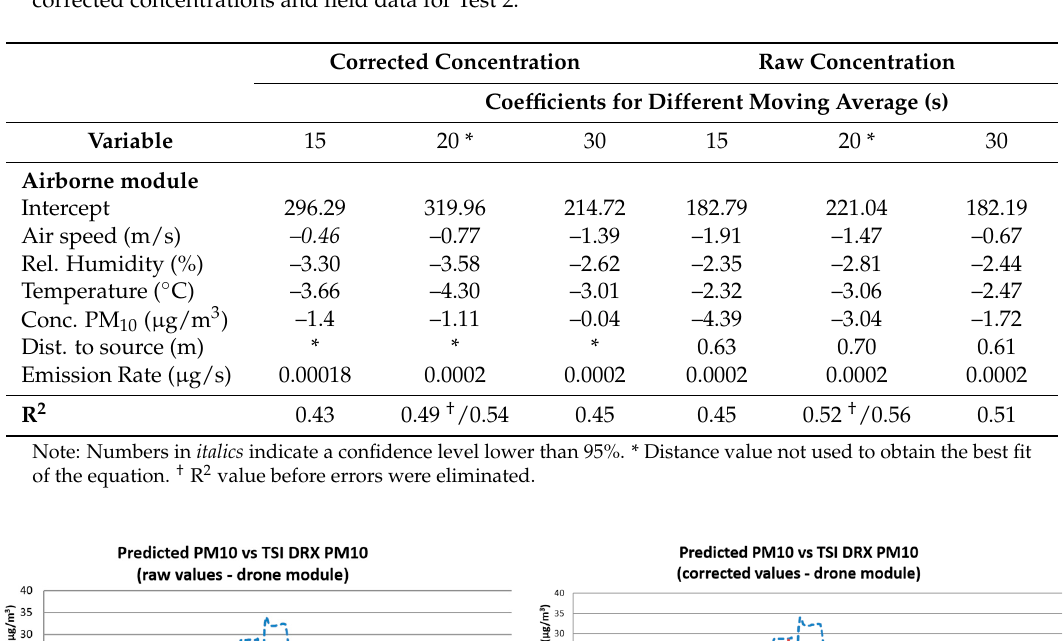
Table 7. Models generated with data collected with the TSI DRX and experimental modules using corrected concentrations and field data for Test 2.